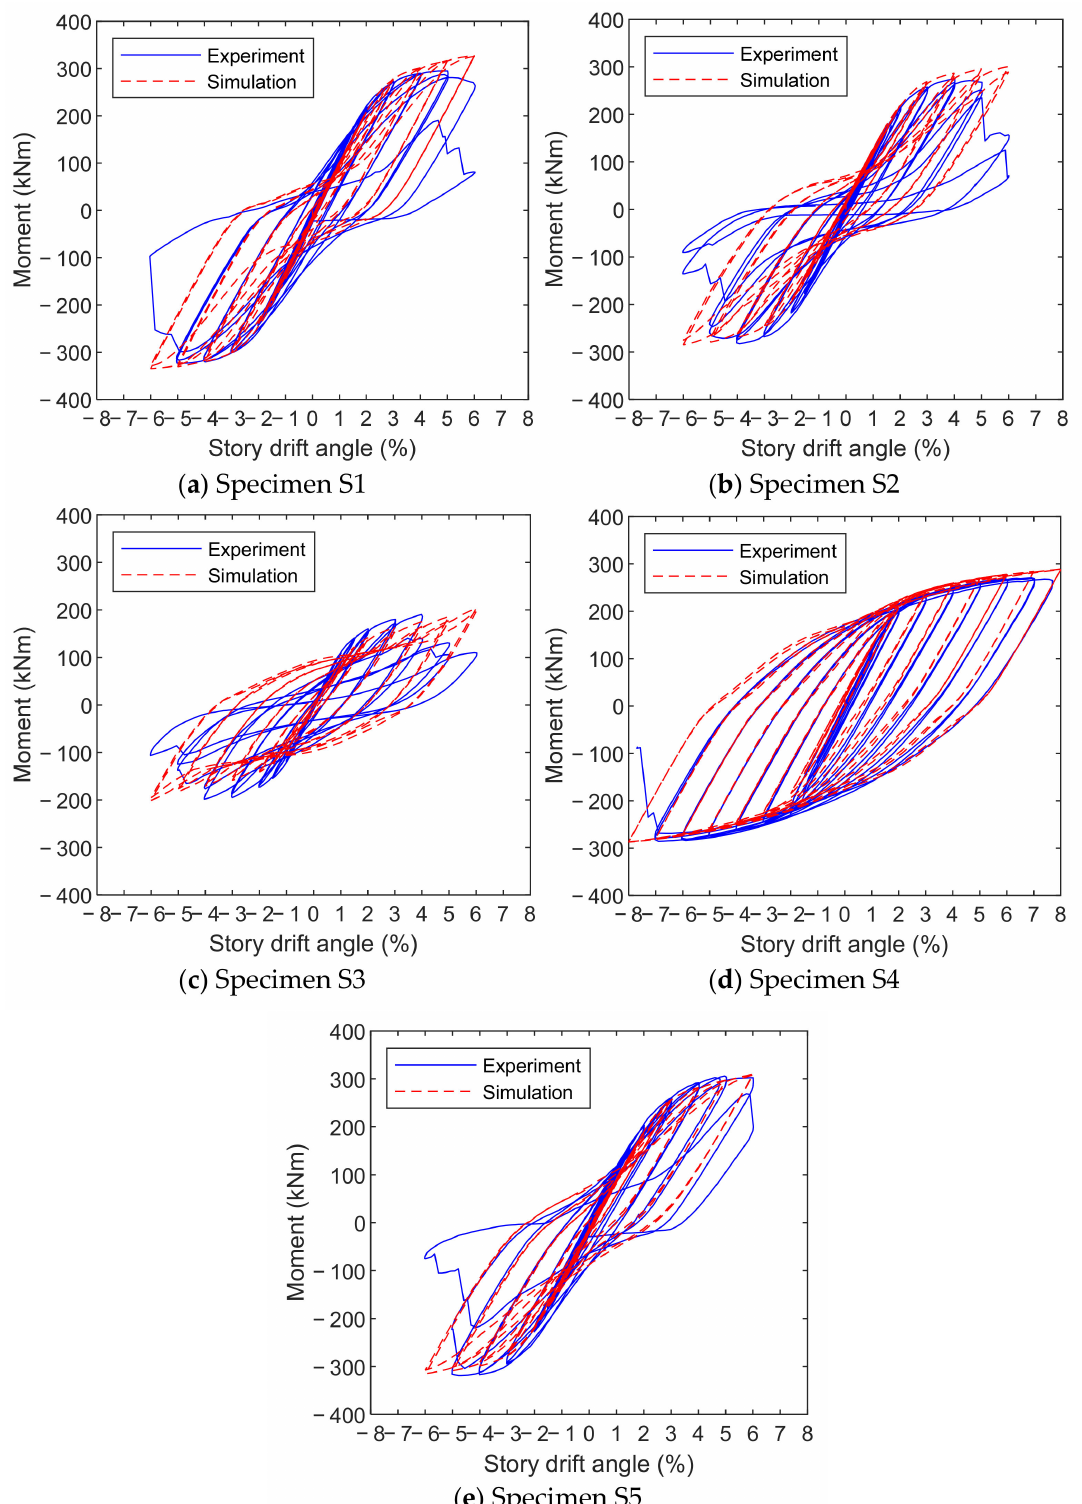
Figure 11. Comparison of experimental and simulated hysteresis loops. The hysteresis loop in specimen S4 was relatively plump since its characteristic was dominated by the weak panel zone subjected to cyclic shear. The satisfactory hysteresis be- havior was accurately captured by the simulation until the bolt fracture occurred